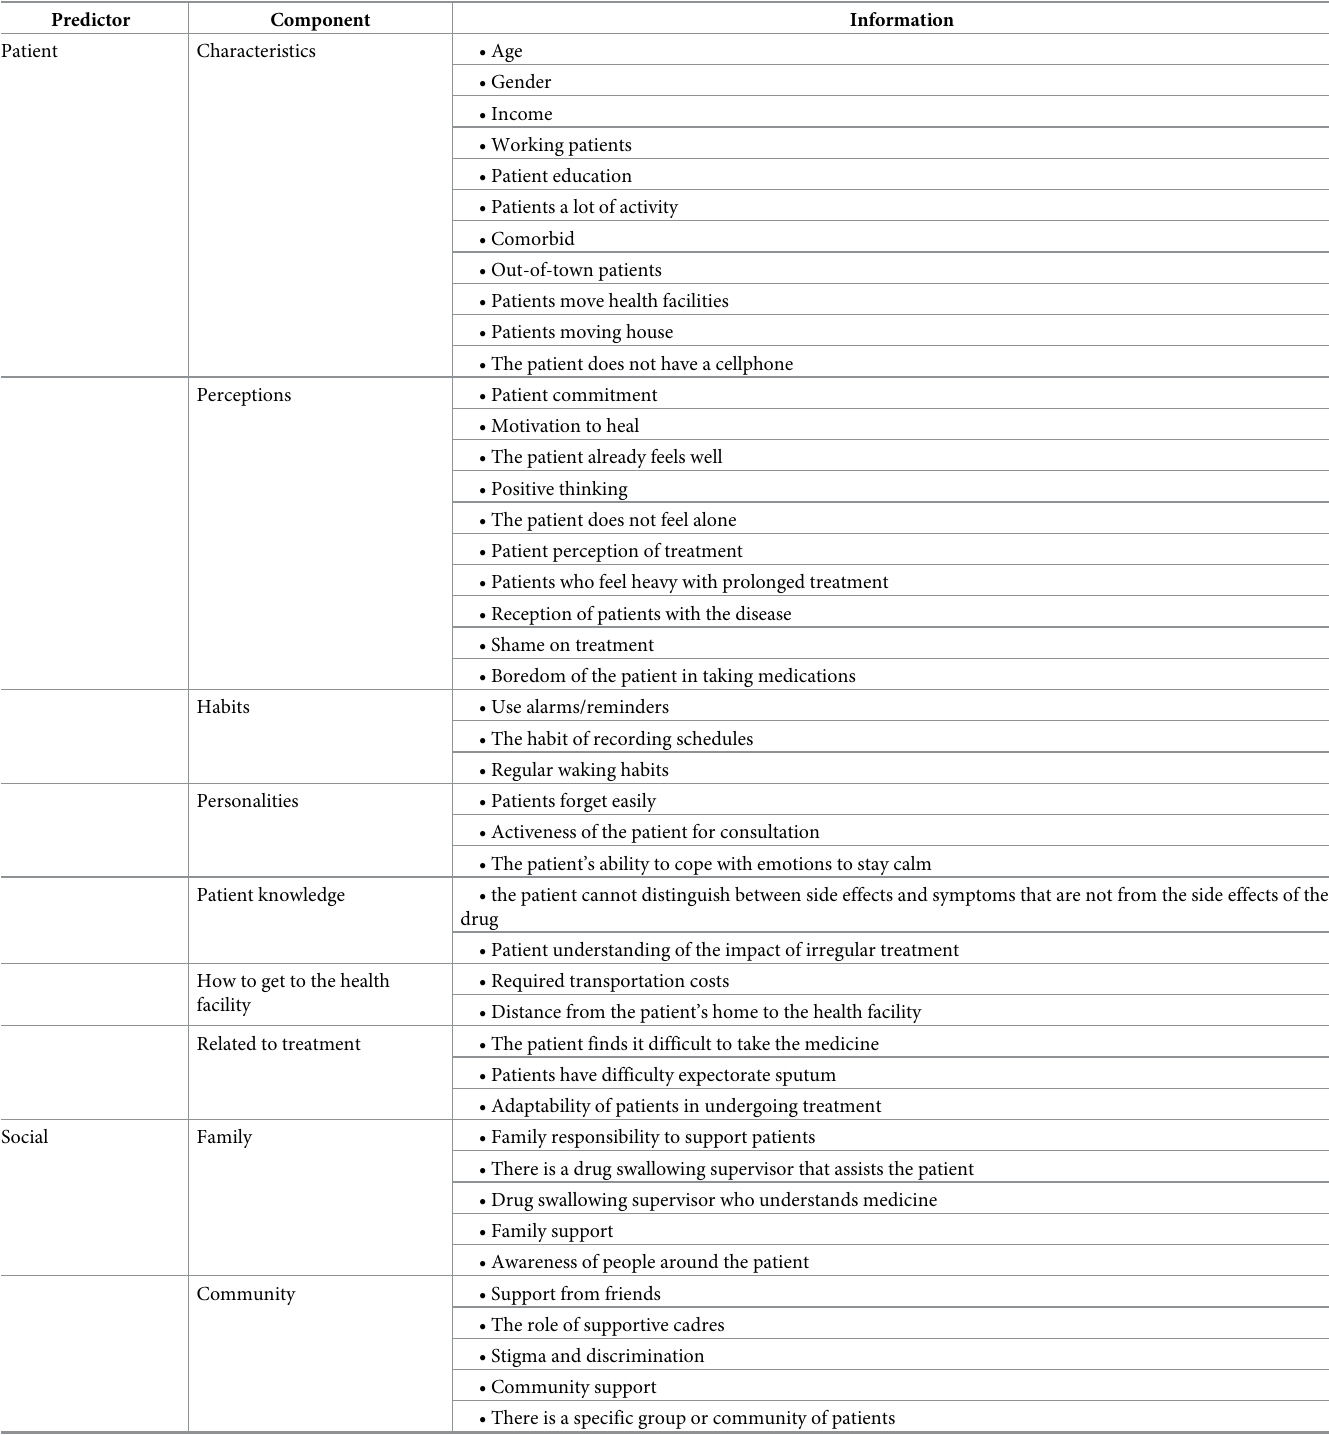
Table 3. The results of the first stage of research (predictors of medication safety).